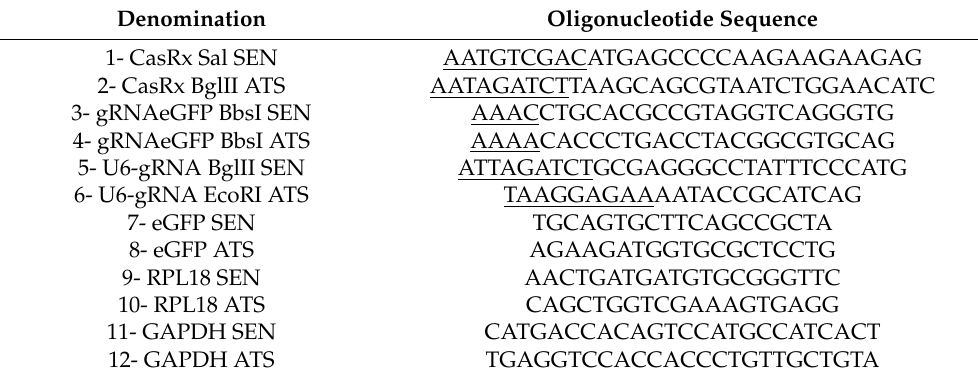
Table 1. Oligonucleotides designed for the construction of newly created plasmids and qRT-PCR analysis.